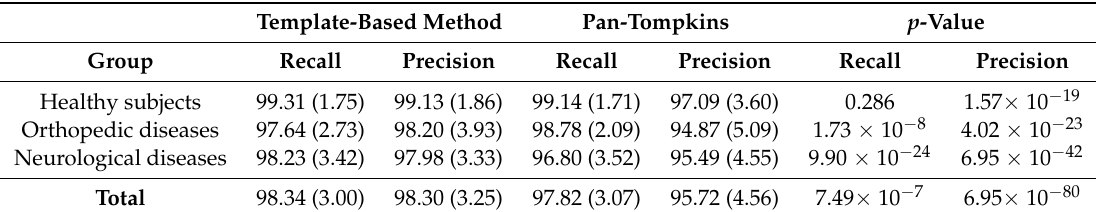
Table 2. Precision and recall scores for the template-based method and the Pan-Tompkins method. Means and standard deviations are displayed, along with p -values of the signed-rank Wilcoxon test.